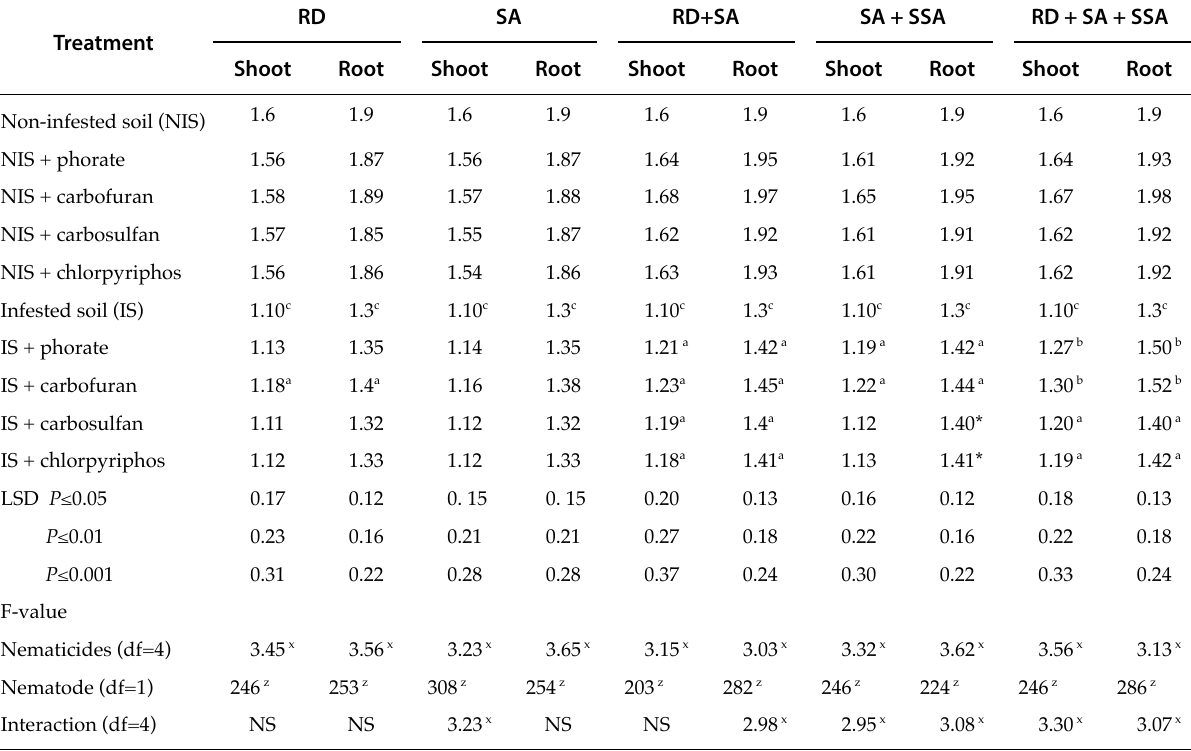
Table 3. Mean shoot and root dry weights (g) of rice plants grown in soil that was either infested or non-infested with Me- loidogyne graminicola and to which different nematicide treatments were applied. RD, root dip; SA, soil application 15 days after transplanting; SSA, second soil application 30 days after transplanting. Each value is mean of ten replicates.